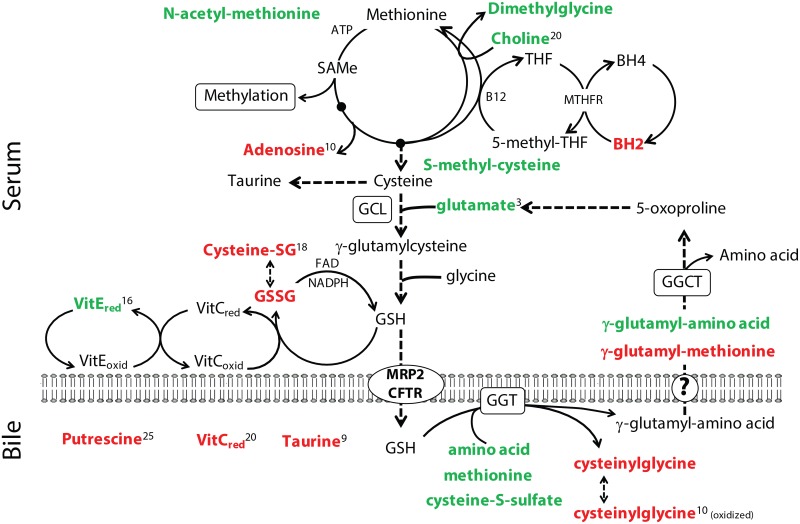
Hypothetical points of intersection of significantly altered compounds with one carbon metabolism, the methionine cycle, glutathione (GSH) synthesis and redox recycling in dogs with gallbladder mucocele formation.Top of Fig represents compounds identified in serum and bottom of Fig represents compounds identified in bile. Compounds in green font were increased and compounds in red font were decreased in dogs with gallbladder mucocele formation in comparison to control dogs. Superscript numbers, when present, indicate rank of the compound as identified by Random Forest analysis as able to distinguish between control dogs and dogs with gallbladder mucocele formation. THF, tetrahydrofolate; BH, hydrobiopterin; GGT, gamma-glutamyl transferase; GGCT, gamma-glutamyl cyclotransferase; GCL, glutamate cysteine ligase.